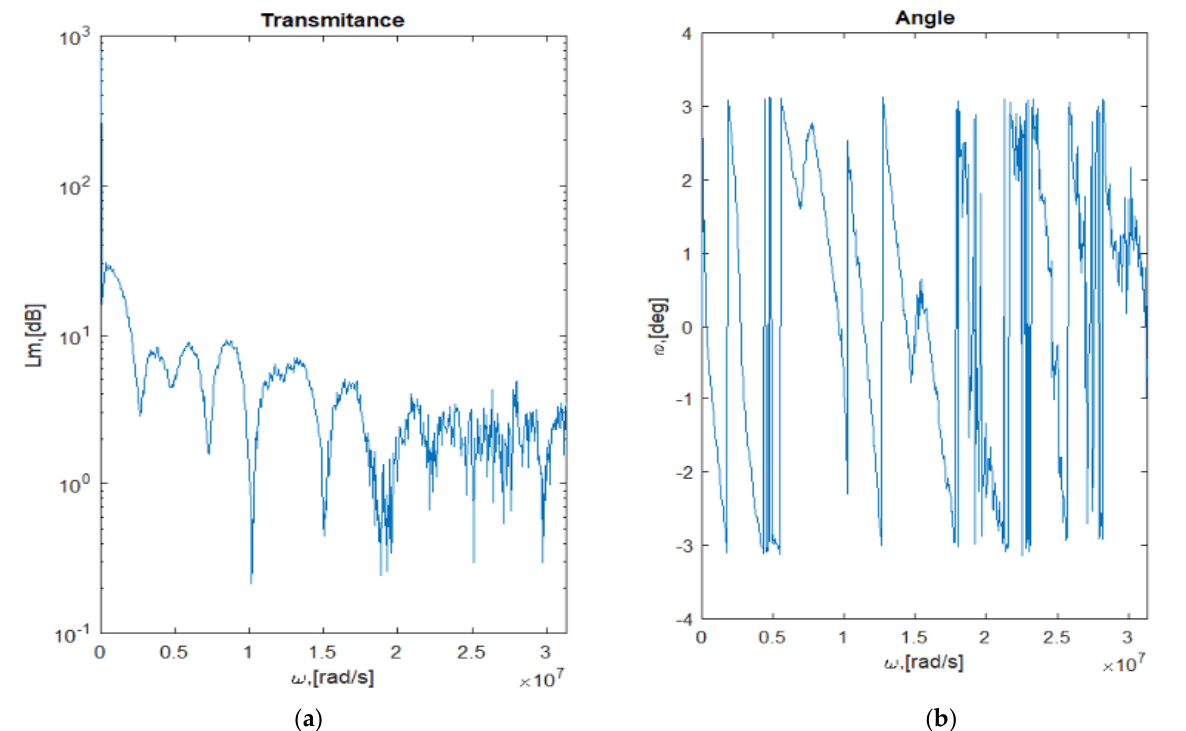
Figure 13. ( a ) Transmittance between pins A and B of the first motor and the GPS terminals; ( b ) Angle of transmittance between pins A and B of the first motor and the GPS terminals.